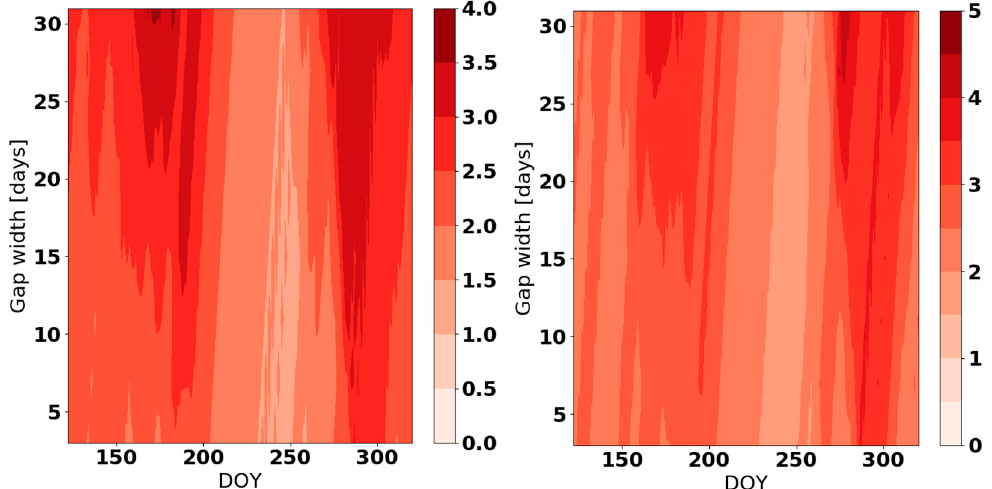
Figure 14. Standard deviation of the observed data which were used for bias correction for the islands